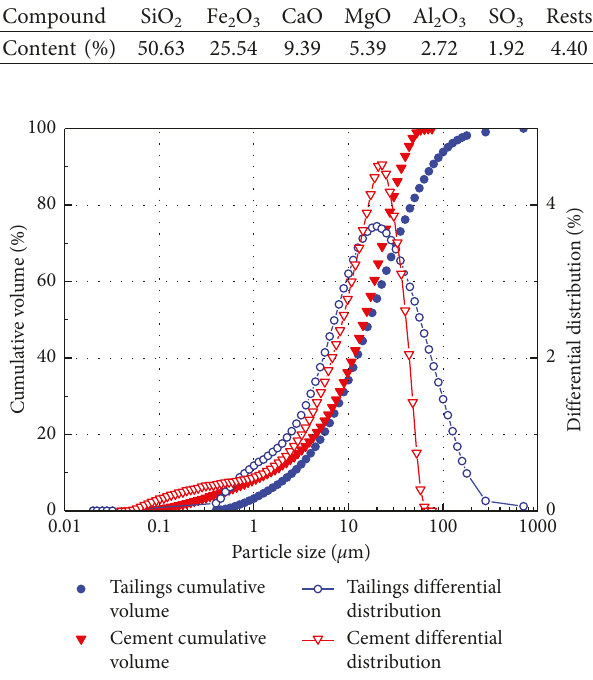
Table 1: Chemical characteristics of the tailings. Compound